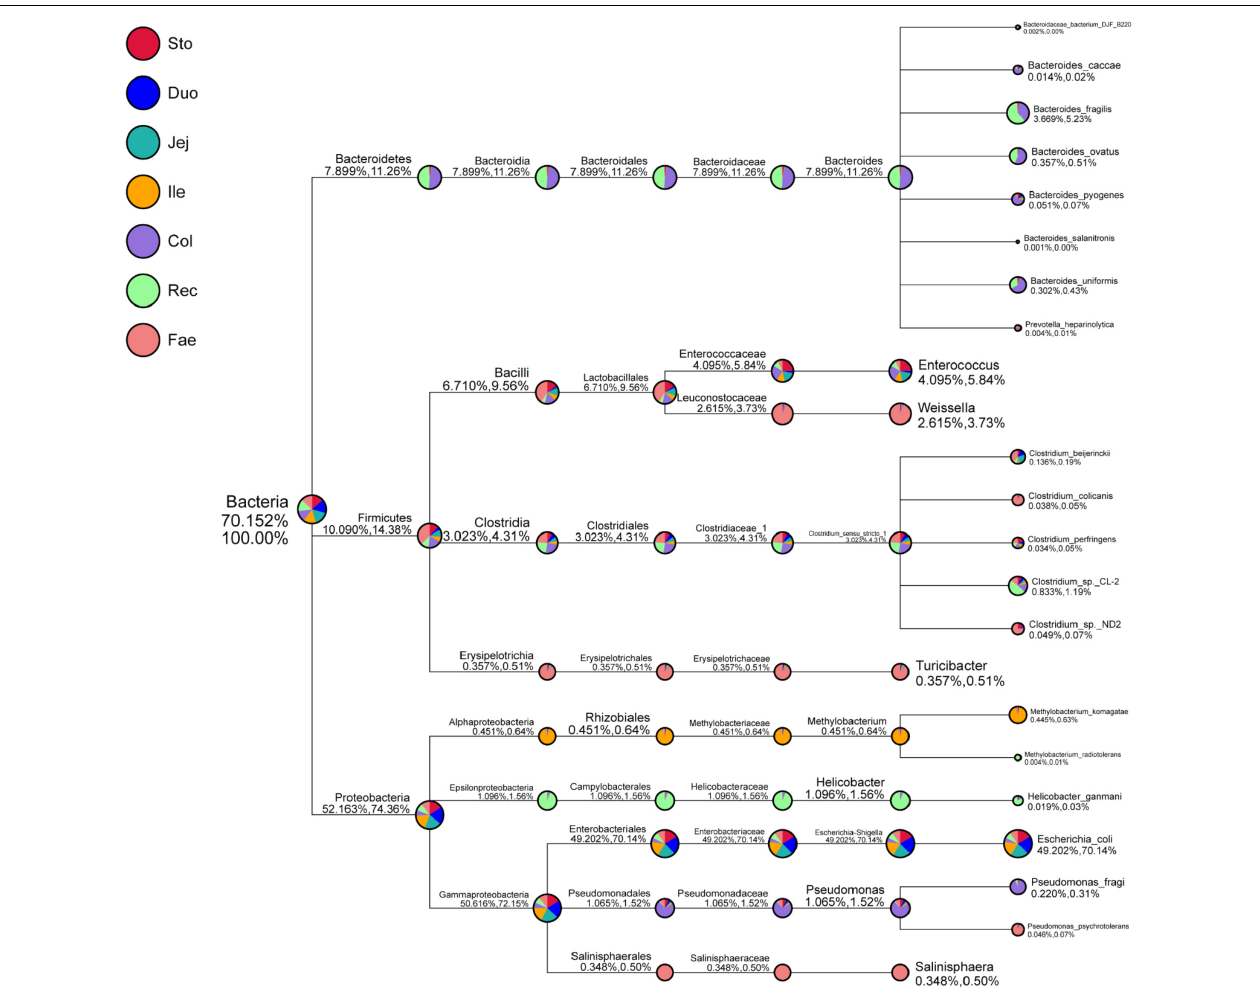
FIGURE 2 | Specific species taxonomy tree analysis of microbiota in red panda GIT. Classification levels include the kingdom, phylum, class, order, family, genus, and species. The first percentile in parentheses shows the percentage of microflora in all the detected bacteria. The second percentile in parentheses shows the percentage of microflora in all the selected bacteria. Sto, Duo, Jej, Ile, Col, Rec, and Fae represent samples from the stomach, duodenum, jejunum, ileum, colon, rectum, and faecal,